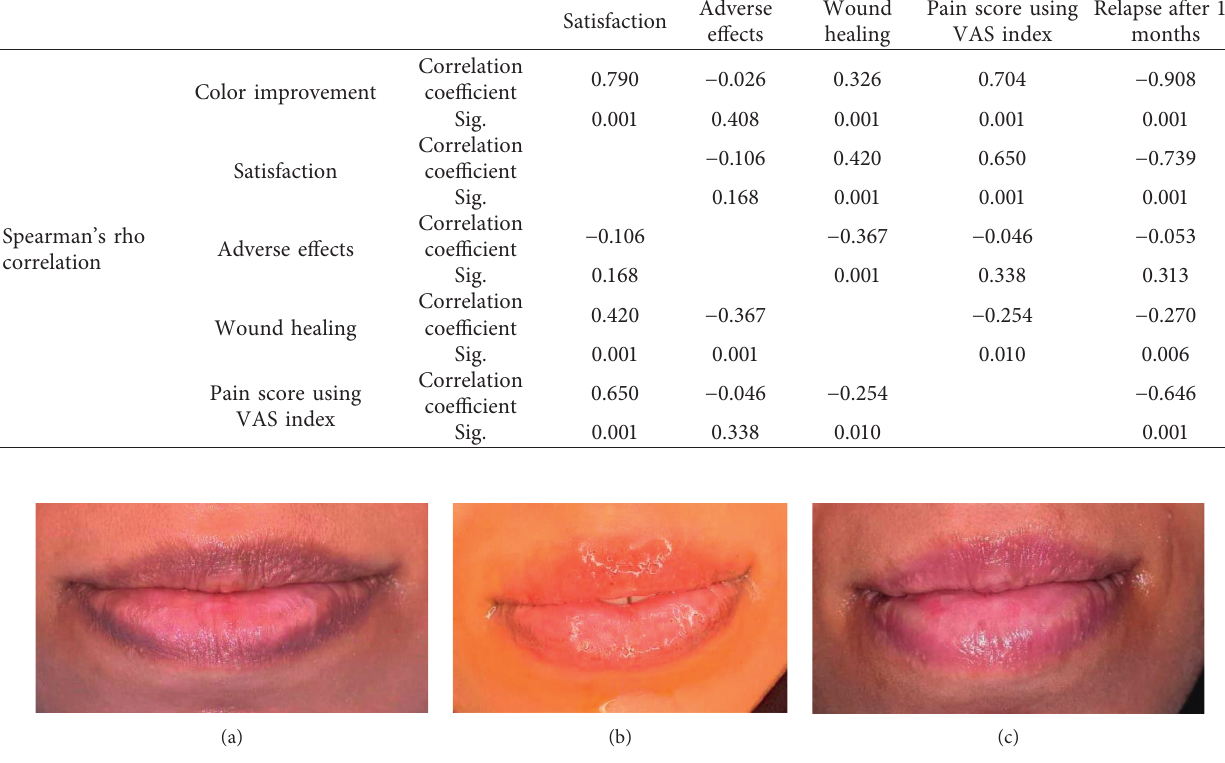
Table 3: Correlation between different outcomes evaluated during Er,Cr :YSGG laser thearpy.